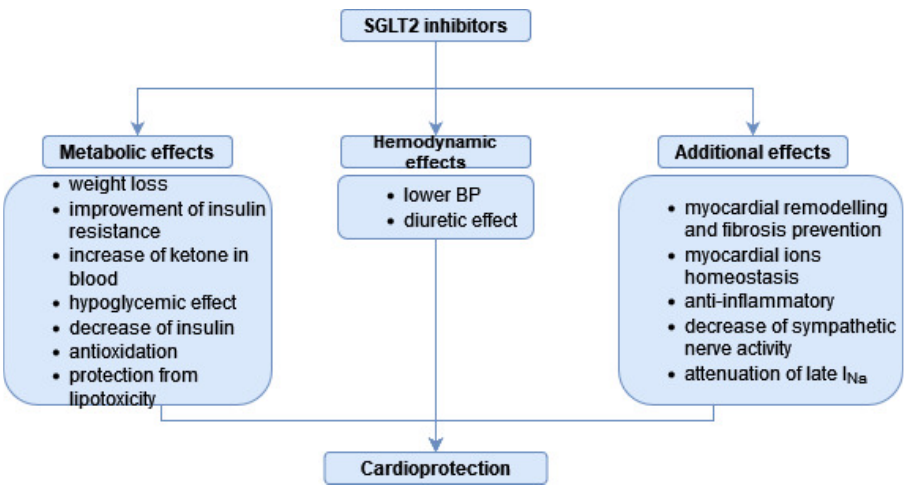
Figure 2. Mechanism of cardioprotection displayed by SGLT ‐ 2is.